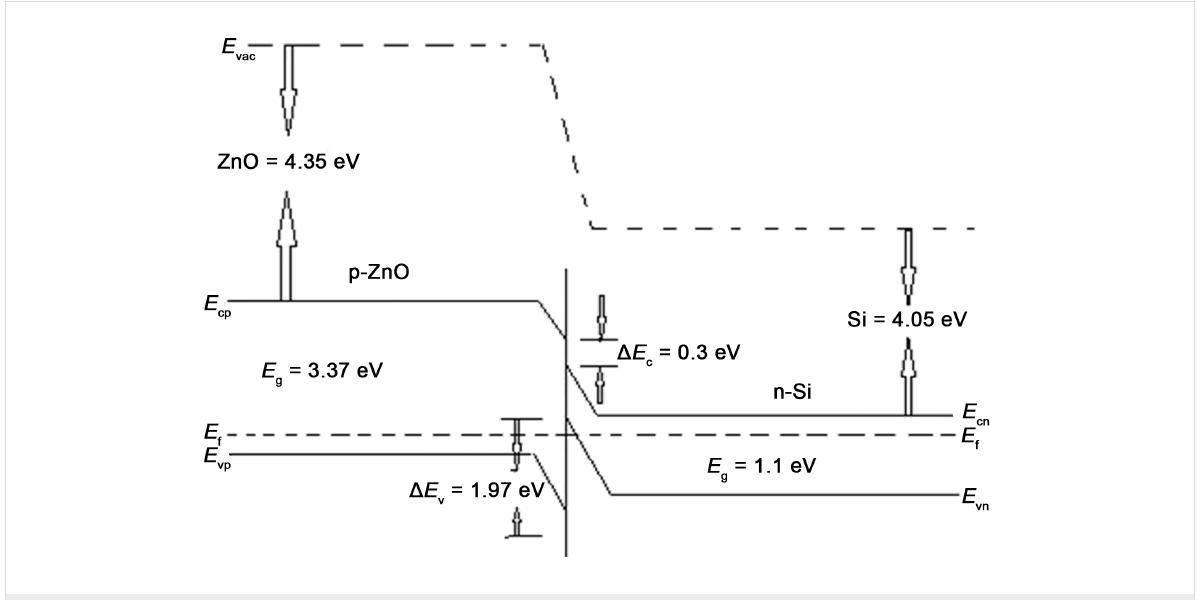
Figure 4: Band diagram of a p-ZnO/n-Si nano heterojunction diode.